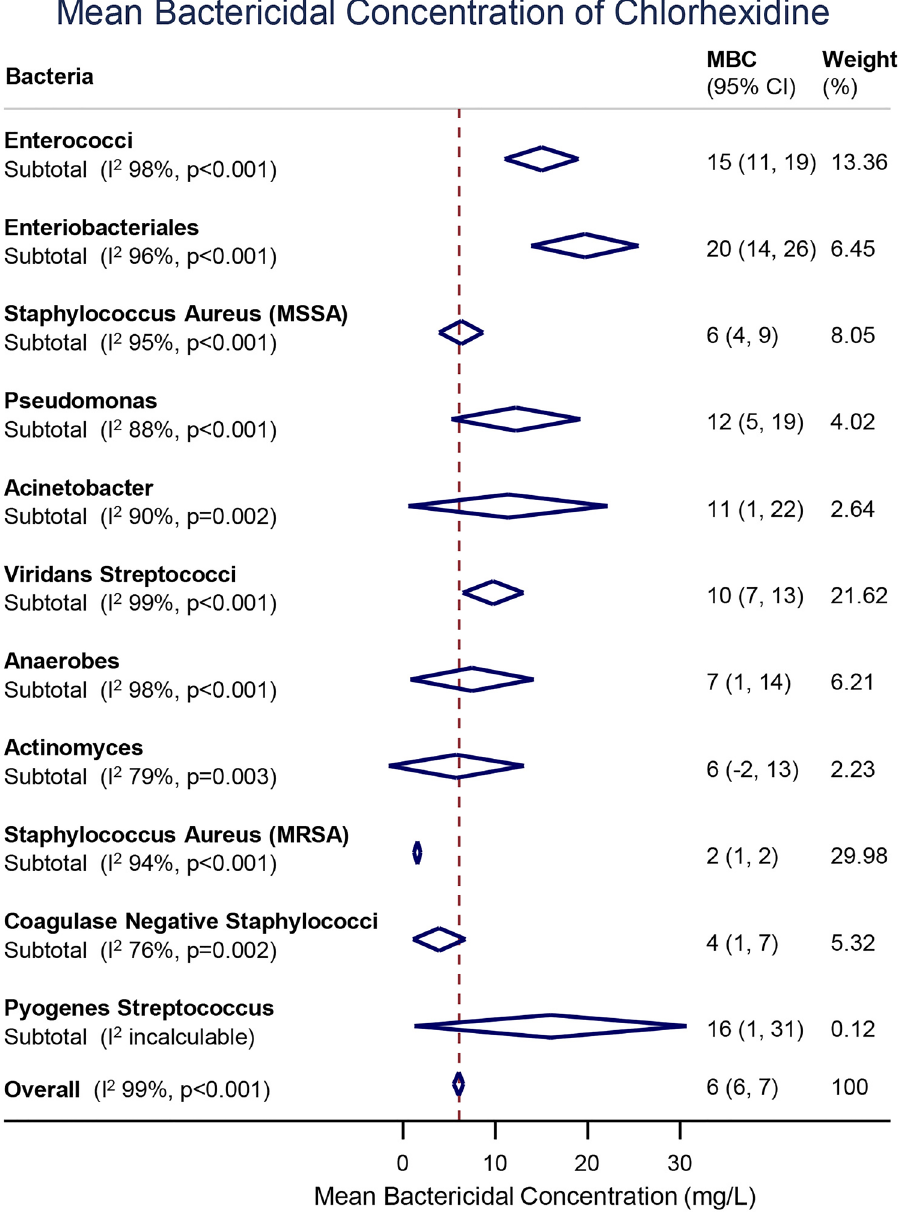
Figure 2. Forest plot of the mean MBC for different species and families of